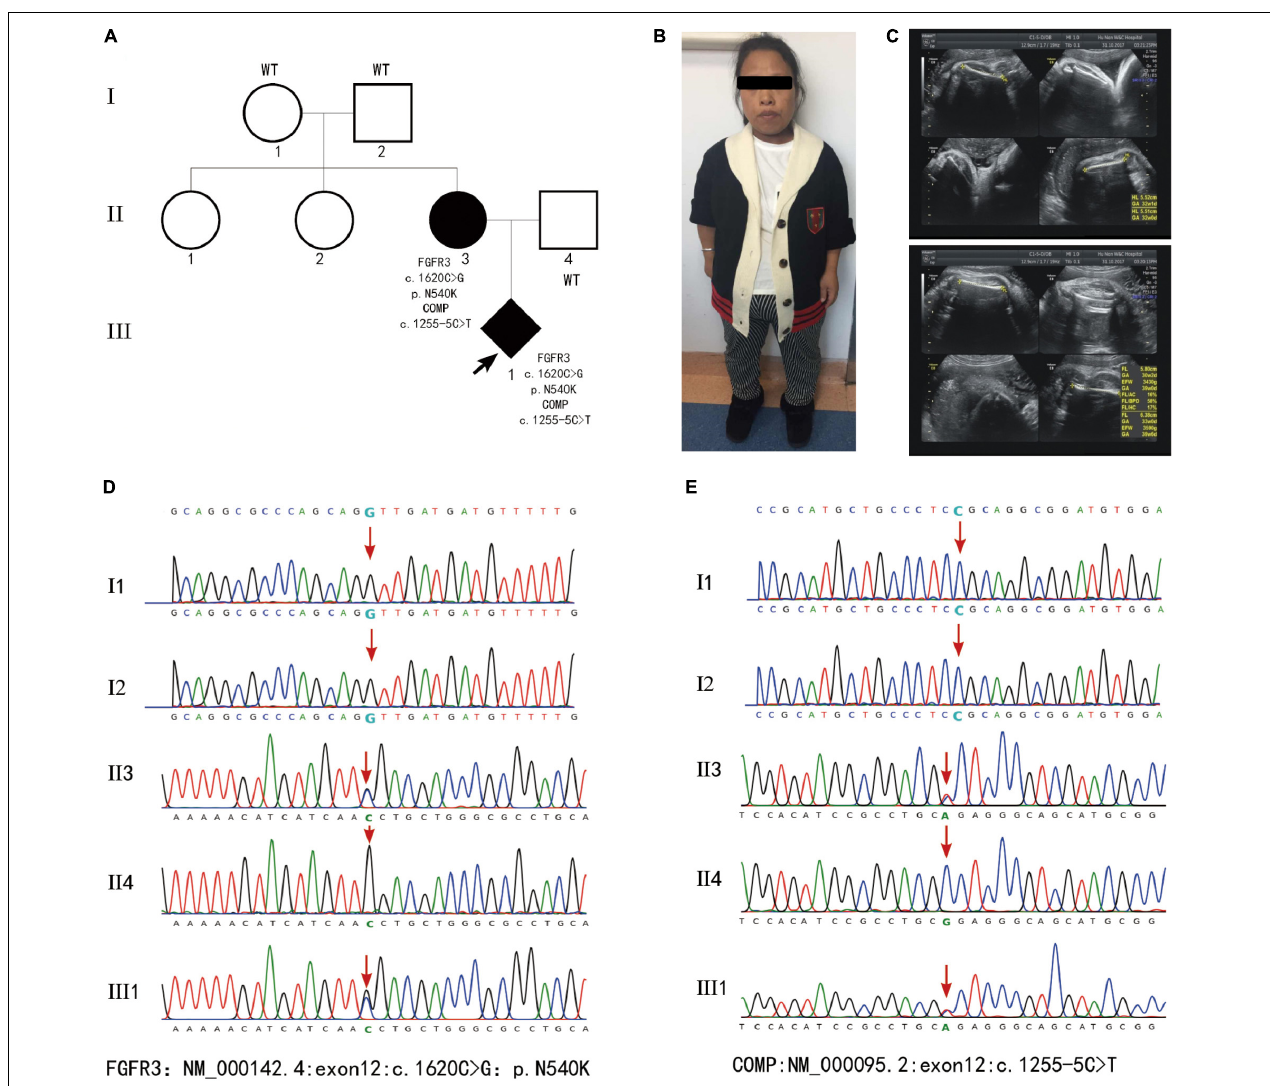
FIGURE 3 | (A) Family pedigrees of fetus 13. (B) Picture of the mother who displayed short stature (135cm in height), slender limbs and lumbar anterior straighten deformity. (C) Images of ultrasound examination of fetus 13 at 40 weeks’ gestation revealed short limbs, curved femur. (D,E) Results of WES. Fetus 13 and the mother who was affected with SDs contained heterozygous mutation FGFR3 :exon12:c.1620C > G:p.N540K and COMP :exon12:c.1255-5C >